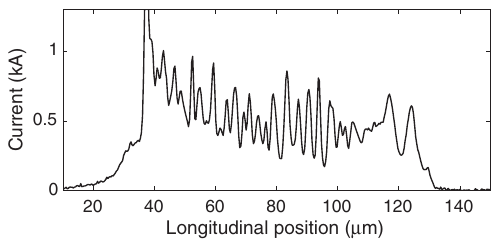
FIG. 3. Current taken from a projection of the upper left image in Fig. 2. Strong modulations show that MBI is nearly saturated without the laser